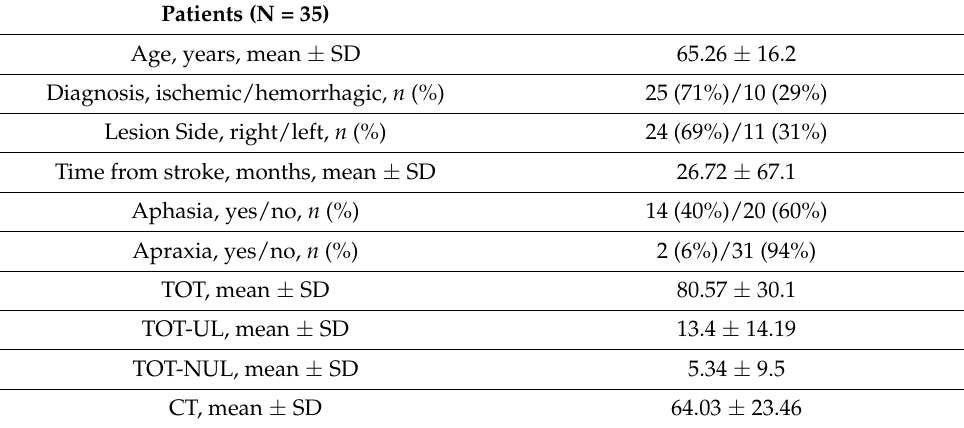
Table 1. Demographic characteristics at baseline (T0) and dose of therapy. Patients (N = 35) Age, years, mean ± SD